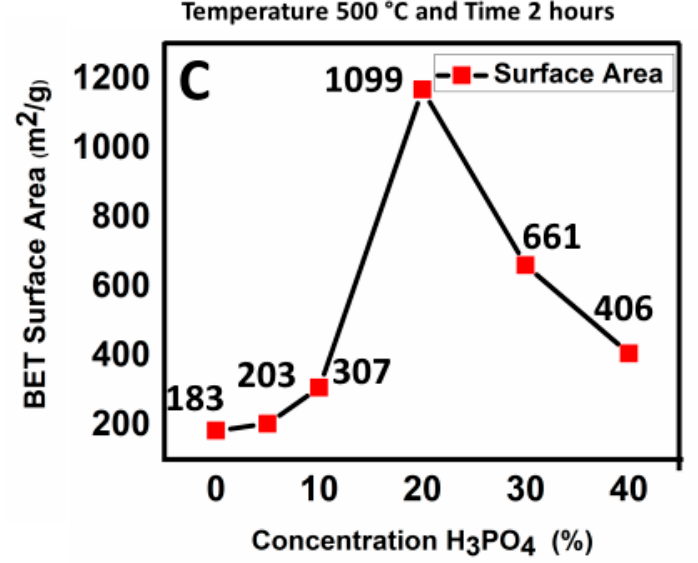
Figure 1. Optimization of temperature, holding time and concentration of phosphoric acid in the synthesis of activated carbon with a flow rate of 1 cm 3 /min of nitrogen gas, showing the effect of temperature ( A ), the effect of holding time ( B ) and the effect of concentration ( C ).